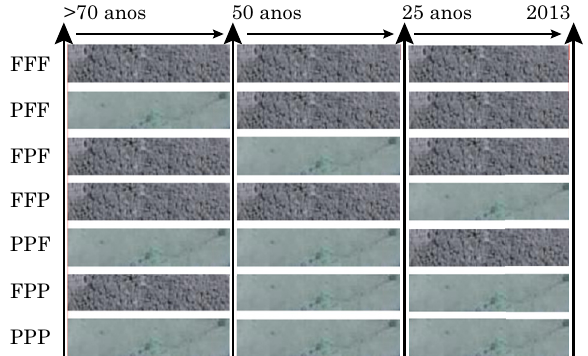
Figura 3. Representação da composição dos tratamentos FFF, PFF, FPF, FFP, PPF, FPP e PPP, em relação ao tempo de uso das terras, >70 anos, 50 anos, 25 anos, até 2013 (ano da coleta do solo). FFF: uso com floresta a mais de 70 anos; FPF: área ocupada nos últimos 25 anos por floresta, antecedida por um período de 25 anos por pastagem e anteriormente por floresta; PFF: uso com florestas nos últimos 50 anos e pastagem no período anterior a 1957; PPF: área ocupada nos últimos 25 anos com floresta, antecedida por pastagem; PPP: uso com pastagem a mais de 70 anos; FFP: uso com pastagem nos últimos 25 anos; e FPP: uso com pastagem nos últimos 25